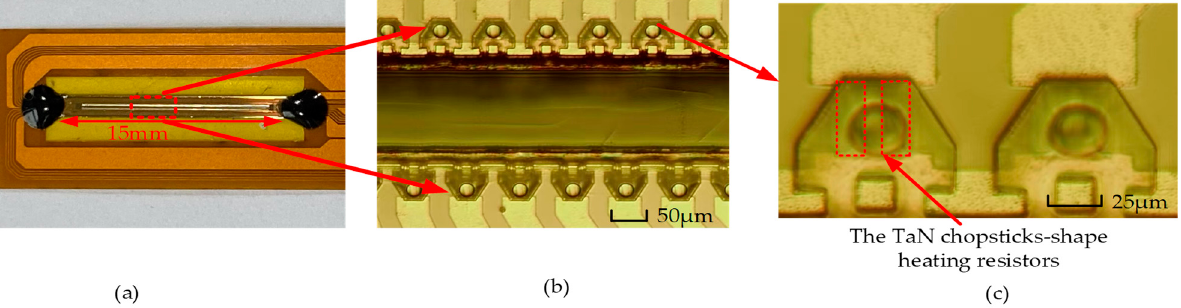
Figure 11. The structure of thermal bubble inkjet chip: ( a ) the overall preview of the thermal bubble inkjet chip; ( b ) the internal structure of the thermal bubble inkjet chip; ( c ) the positions of the TaN chopsticks-shaped heating resistors.